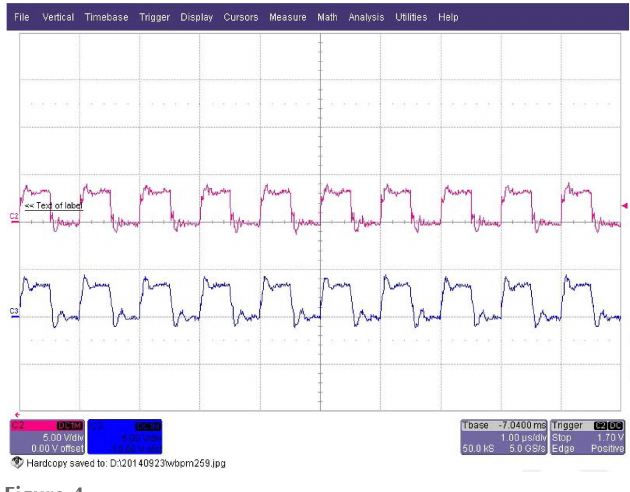
Figure 4 Two channels of hardware trigger signals: one is for the ADC, the other is for the scaler.